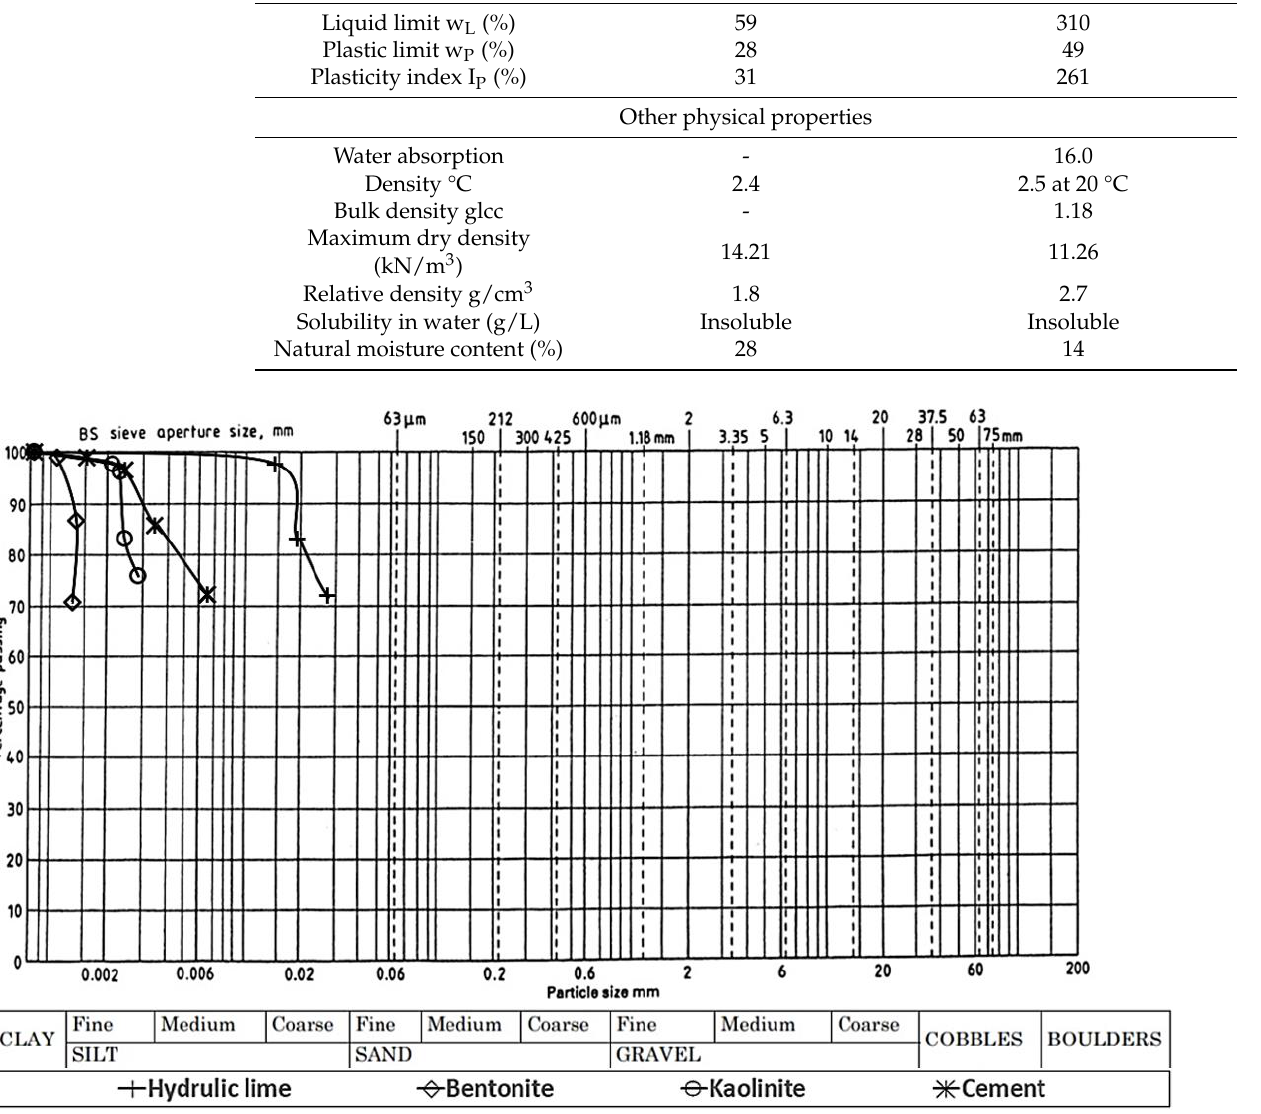
Figure 2. Particle size distribution of materials used in this